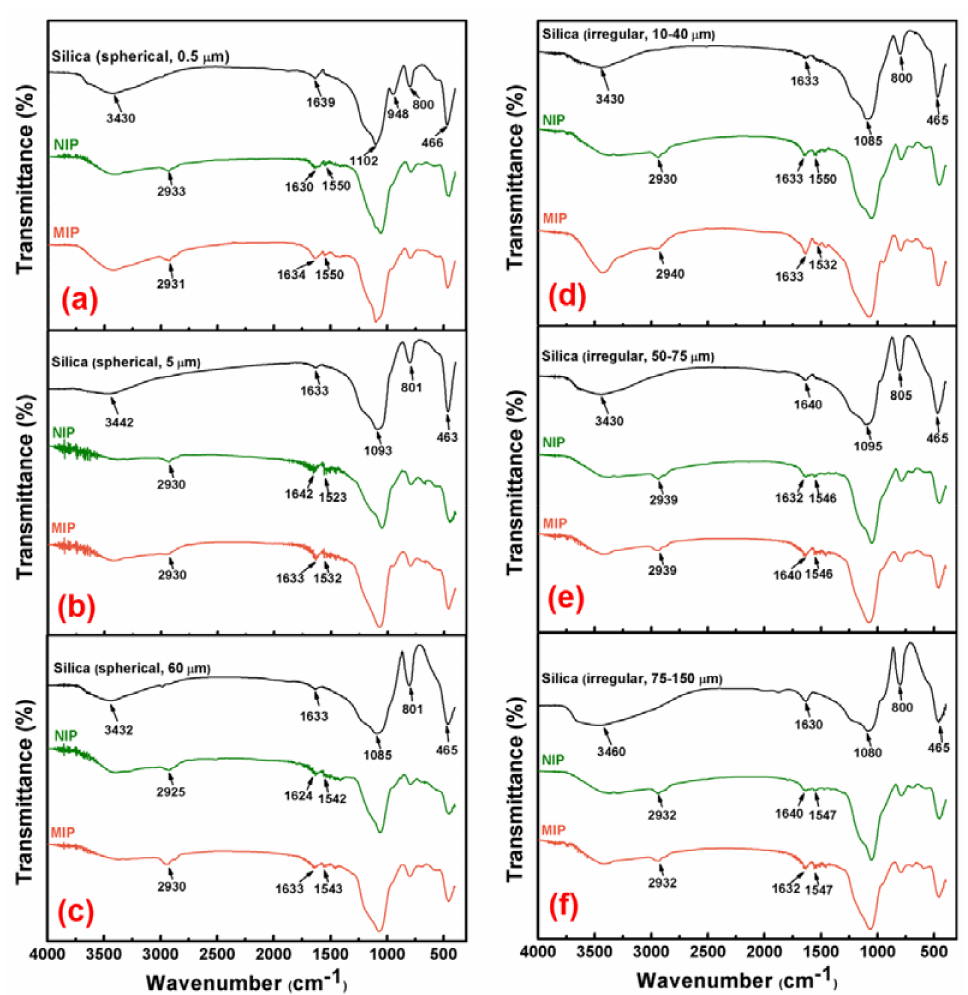
Figure 2. FT-IR spectra of silica support and its corresponding NIP and MIP. ( a ) spherical 0.5 µ m, ( b ) spherical 5 µ m, ( c ) spherical 60 µ m, ( d ) irregular 10–40 µ m, ( e ) irregular 50–75 µ m, and ( f ) irregular 75–150 µ